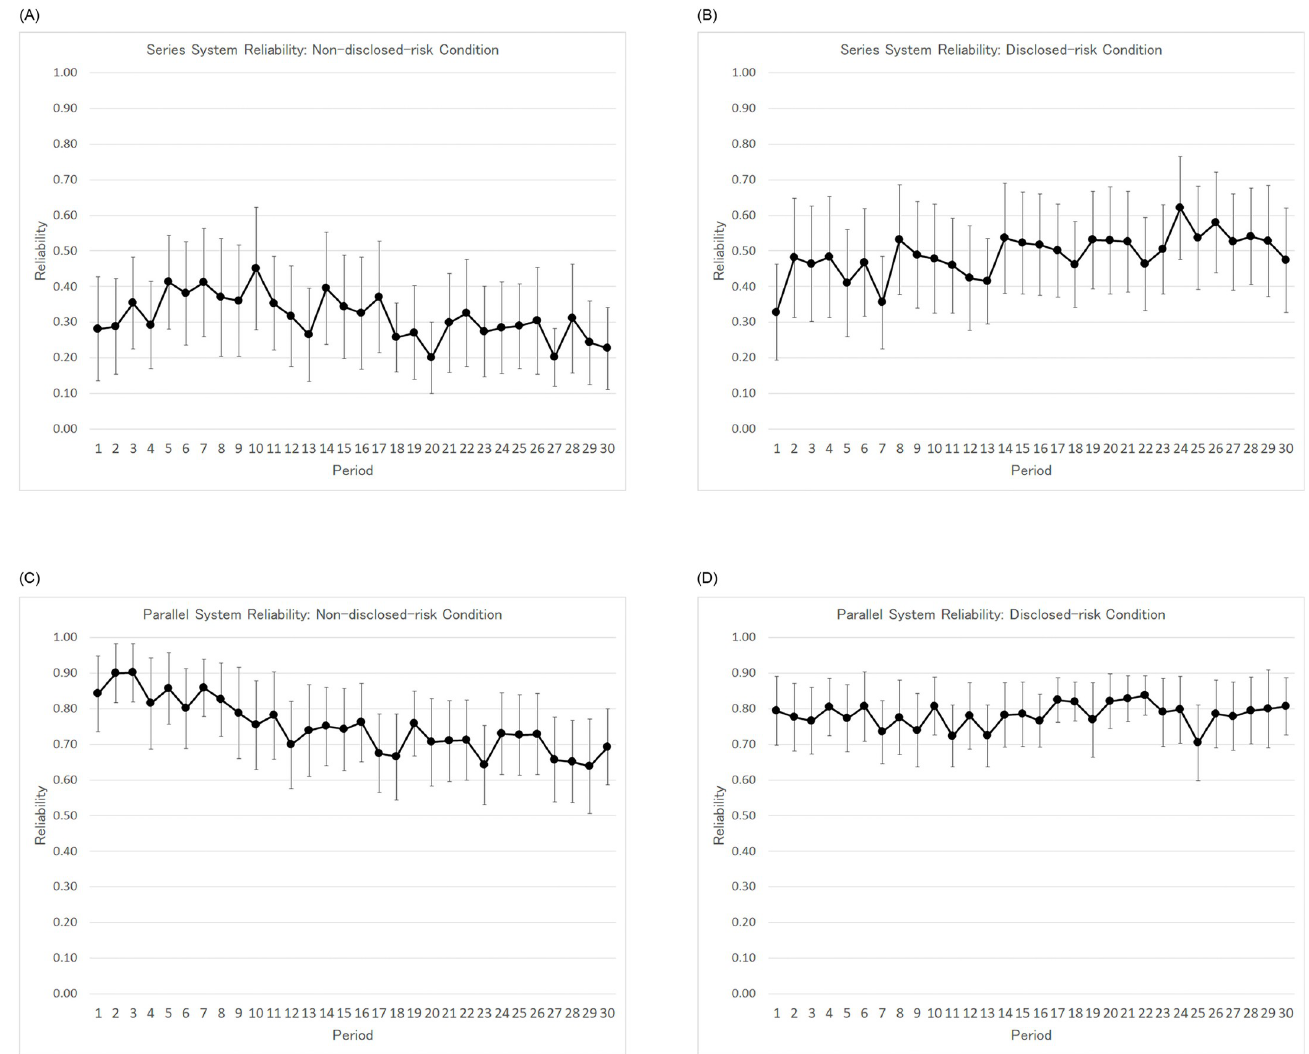
Fig 4. A-D. Average and standard deviation of each period’s system